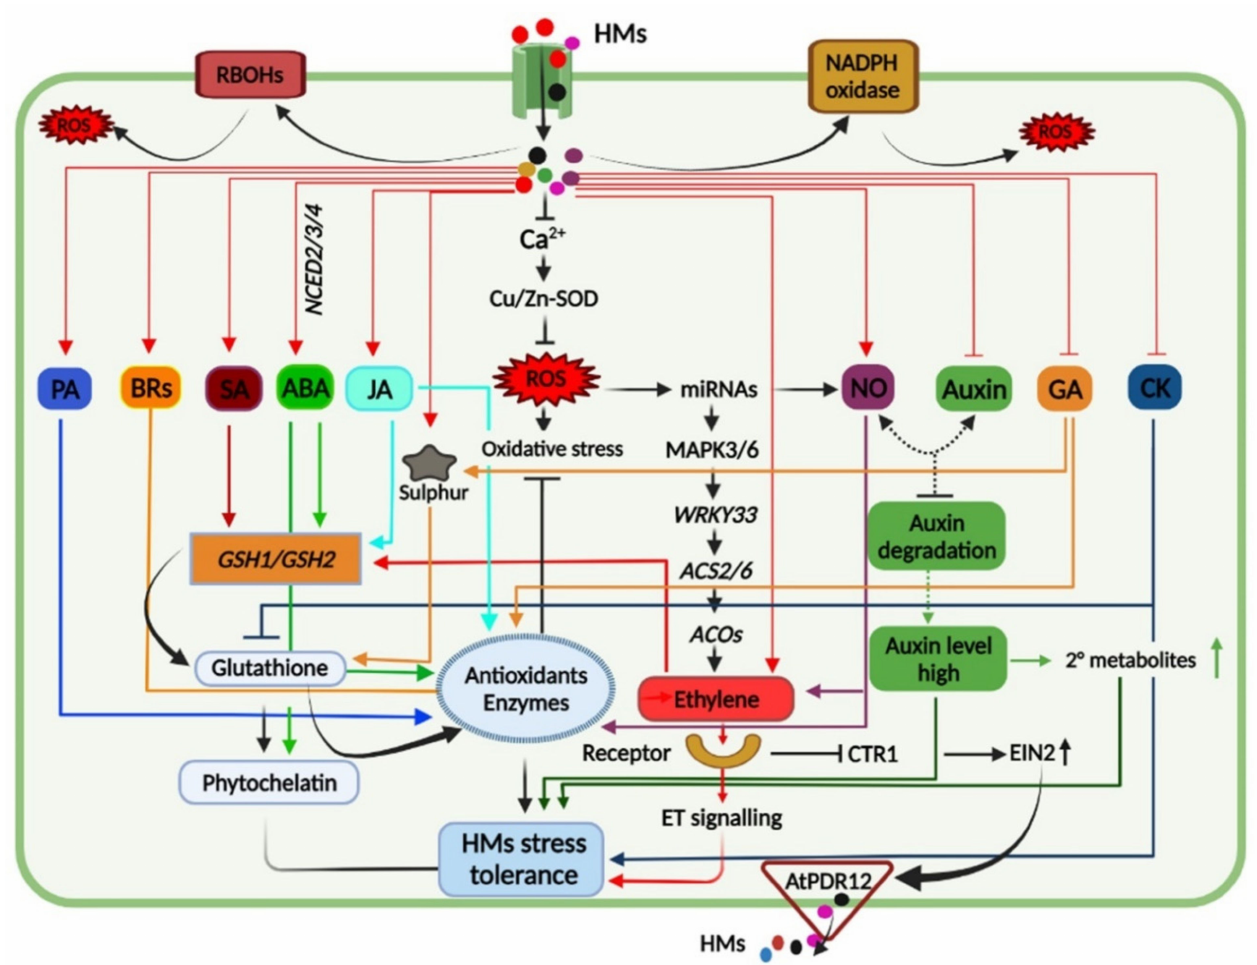
Figure 3. A graphical depiction highlighting interactions and crosstalk among phytohormones in- cluding abscisic acid (ABA), jasmonic acid (JA), salicylic acid (SA), brassinosteroids (BRs), polyamines (PA), ethylene, auxin, nitric oxide (NO), gibberellic acid (GA), and cytokinin (CK) under heavy metal exposure. HMs treatments increase endogenous levels of PA, BRs, SA, ABA, JA, ET, NO, and ROS amounts while the levels of auxin, GA, and CK were inhibited. The ROS produced in response to HM stress either by respiratory burst oxidase homolog (RBOH) activity and NADPH oxidase or by alteration in electron transport is also known to activate signal transduction. Alteration of these hormones and imbalance of ROS equilibrium leads to induction of antioxidant defense mechanism and HMs detoxification by promoting glutathione and phytochelatin biosynthesis, thus regulating HM stress tolerance to